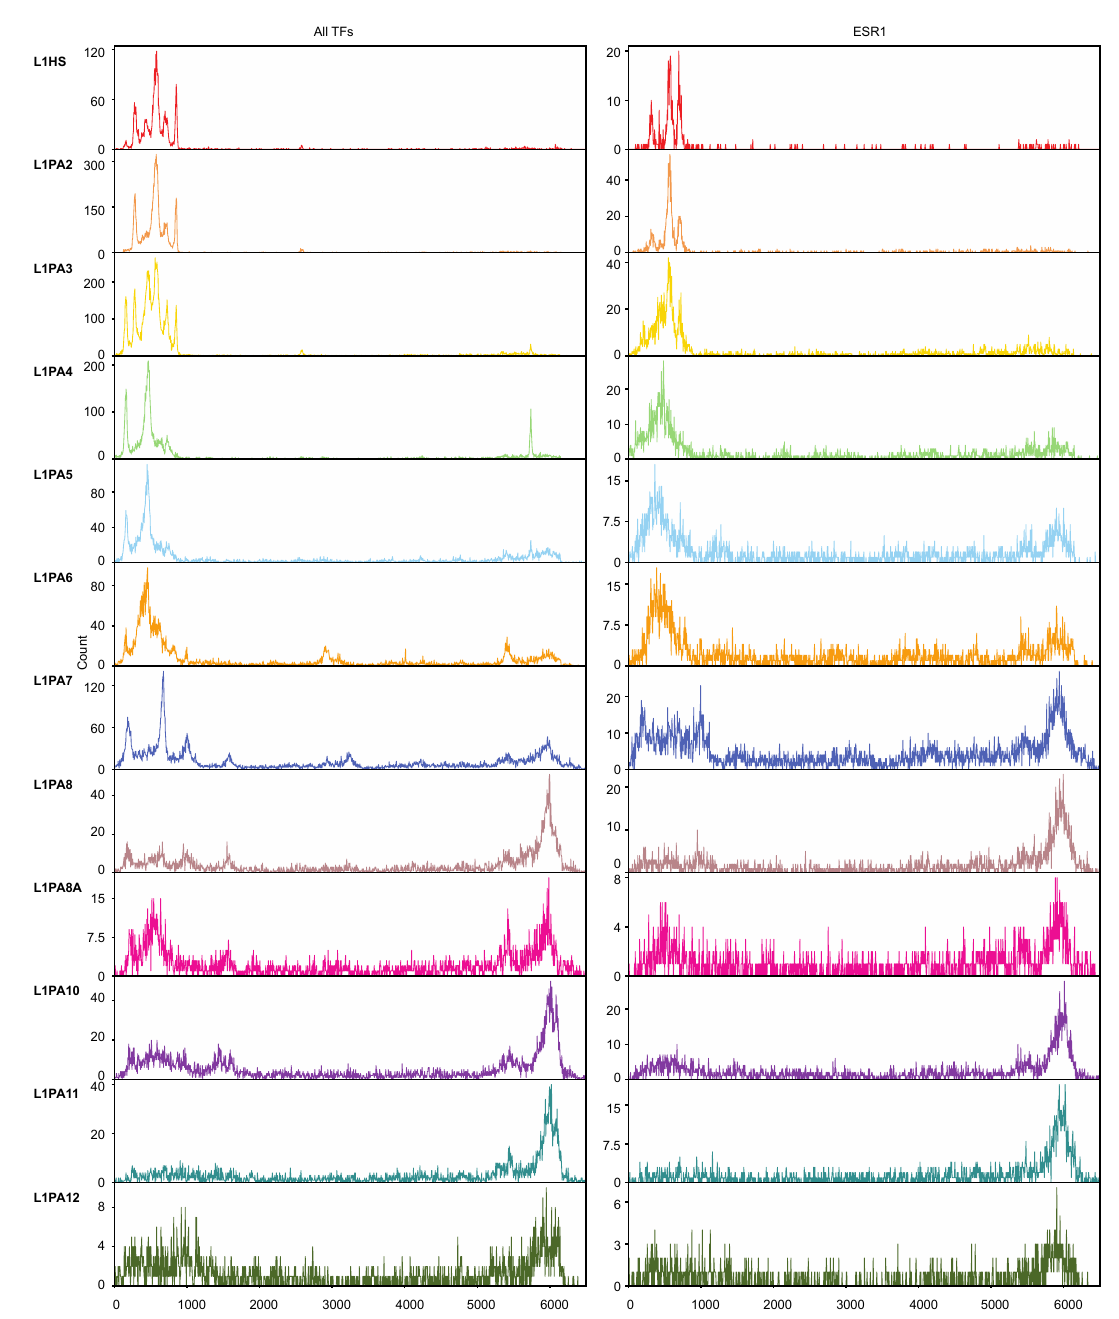
Figure 4. Truncated L1 transposons lacking 5 ′ UTRs contributed to TF binding through alternative binding sites in the 3 ′ ends. The histograms (bin = 5 bp) show the distribution of TFBSs of all TFs (left) and ESR1 (right) in the consensus sequences of each L1 subfamily (up to 6500 bp). The relative positions of TFBSs in the consensus sequences were calculated using the “RepStart” and “RepEnd” information from RepeatMasker [51].